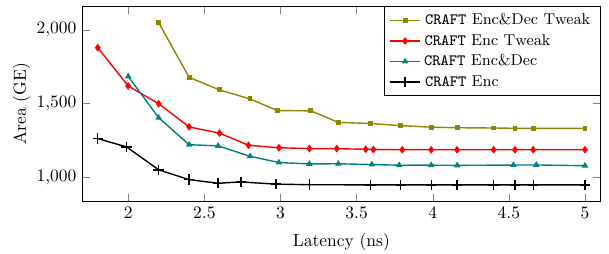
Figure 9: Latency versus area of unprotected round-based CRAFT , using the IBM 130 nm ASIC